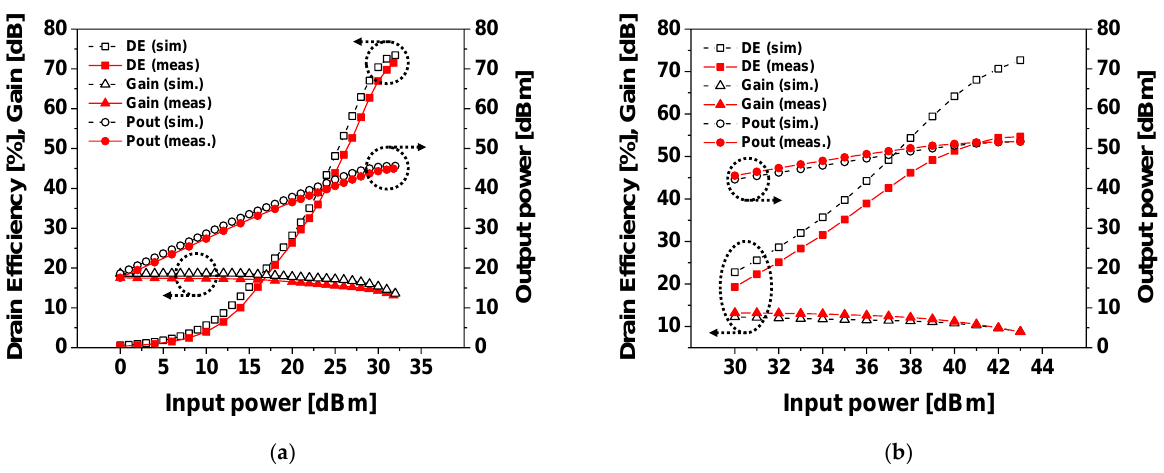
Figure 3. Simulated and measured RF characteristic of ( a ) the drive and ( b ) the main PA test unit. Using the above two types of transistors, a 2-stage PA test unit was fabricated, as shown in Figure 4a. Isolators, ADI240CET, were used at the input/output terminal of the 2-stage PA to avoid damage to the power amplification part caused by the reflected power in case of a mismatch. The PCB used for the power amplification part was a RT/duroid ® 6010.LM (Rogers Corporation, Chandler, USA). The 2-stage PA was designed considering stability to ensure reliability. The stability is determined by Rollet’s factor, K, using network scattering parameters [12]. The stability factor of K is required to be larger than 1 at least to prevent oscillation; thus, it was confirmed that is K > 1 in the design and measurement. Moreover, the negative resistance was checked whether it existed at the input and output nodes or not. The DC bias of the drive and the main PA used V MAIN_GG = V DRV_GG = –2.7 V and V MAIN_DD = V DRV_DD = 30 V, respectively. As the measurement of the 2-stage PA was fabricated as a test unit, liquid cooling was not available, so it proceeded under a duty cycle of 10% pulsed wave. Figure 4b shows the measurement results. The output power reached over 53 dBm at 2.4 GHz and the adjacent frequency. The average value of the measured gain was 23 dB, and an average drain efficiency of over 50% was achieved.